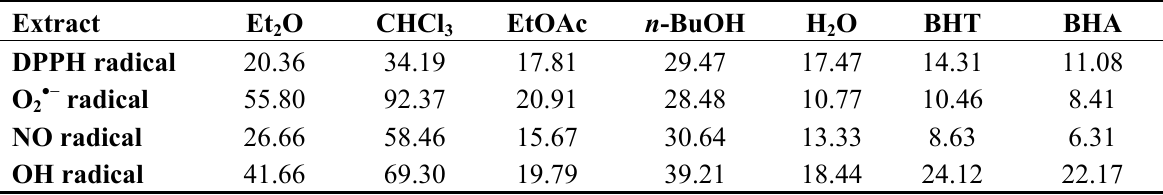
Table 2. IC values ( μ g/mL) of extracts of T. pratense and standards (BHT and BHA) for 50 different antioxidant